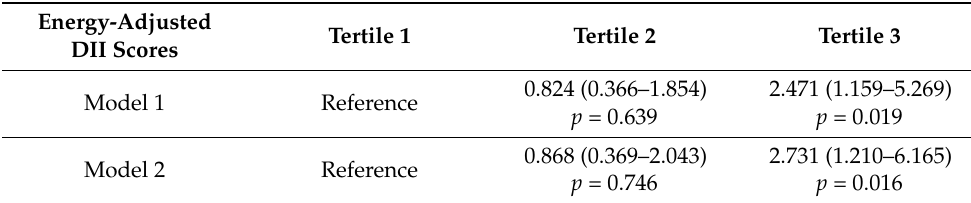
Table 7. Odds ratios (95% confidence intervals) for schizophrenia according to the tertiles of energy- adjusted dietary inflammatory index (E-DII)